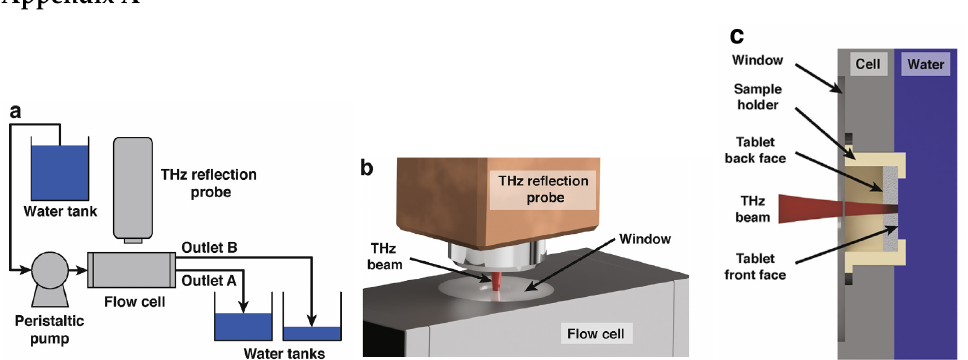
Figure A1. Experimental setup of the TPI coupled with a flow cell. ( a ) Schematic representation of the flow loop. ( b ) 3D visualisation of the terahertz reflection probe and the flow cell. ( c ) Cross-section demonstration of the flow cell (modified from